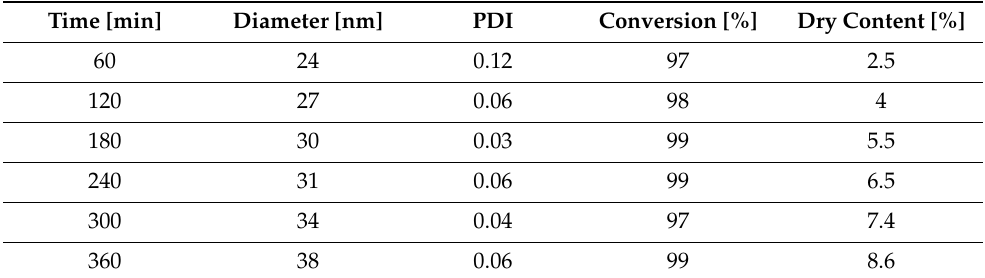
Table 2. Overview of Diameter, Polydispersity Index (PDI), conversion and dry content during the emulsion polymerization.